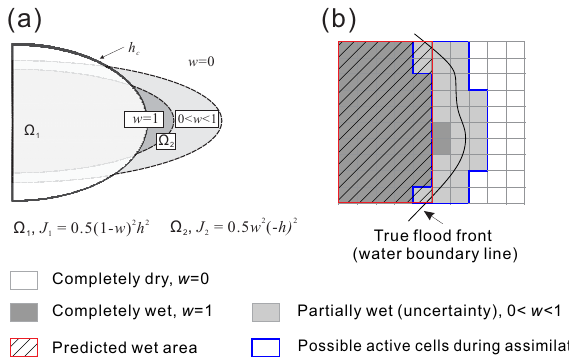
Figure 1. Definition of a cost function. (a) The concept map; (b) grid-based map for showing the specific definition of cost func- tion and possible active cells during data